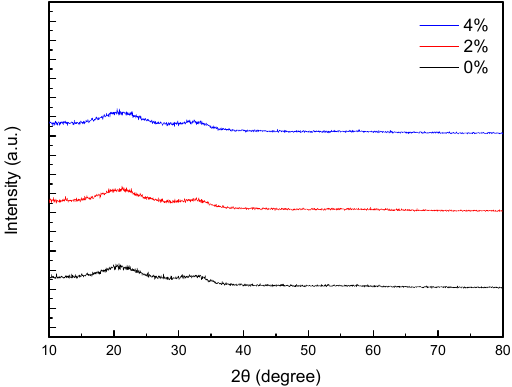
ff erent oxygen flow